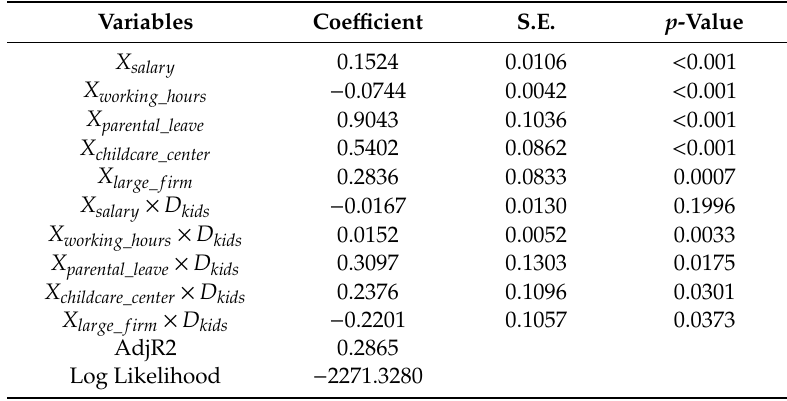
Table 13. Estimation results of the indirect utility function, by pregnancy